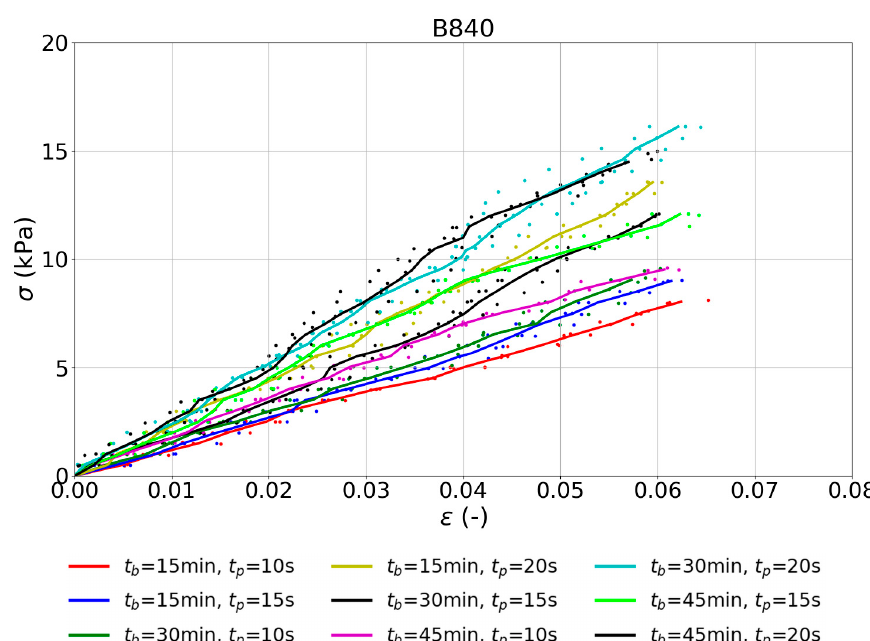
Figure 8. Stress–strain relations for mixes B840.